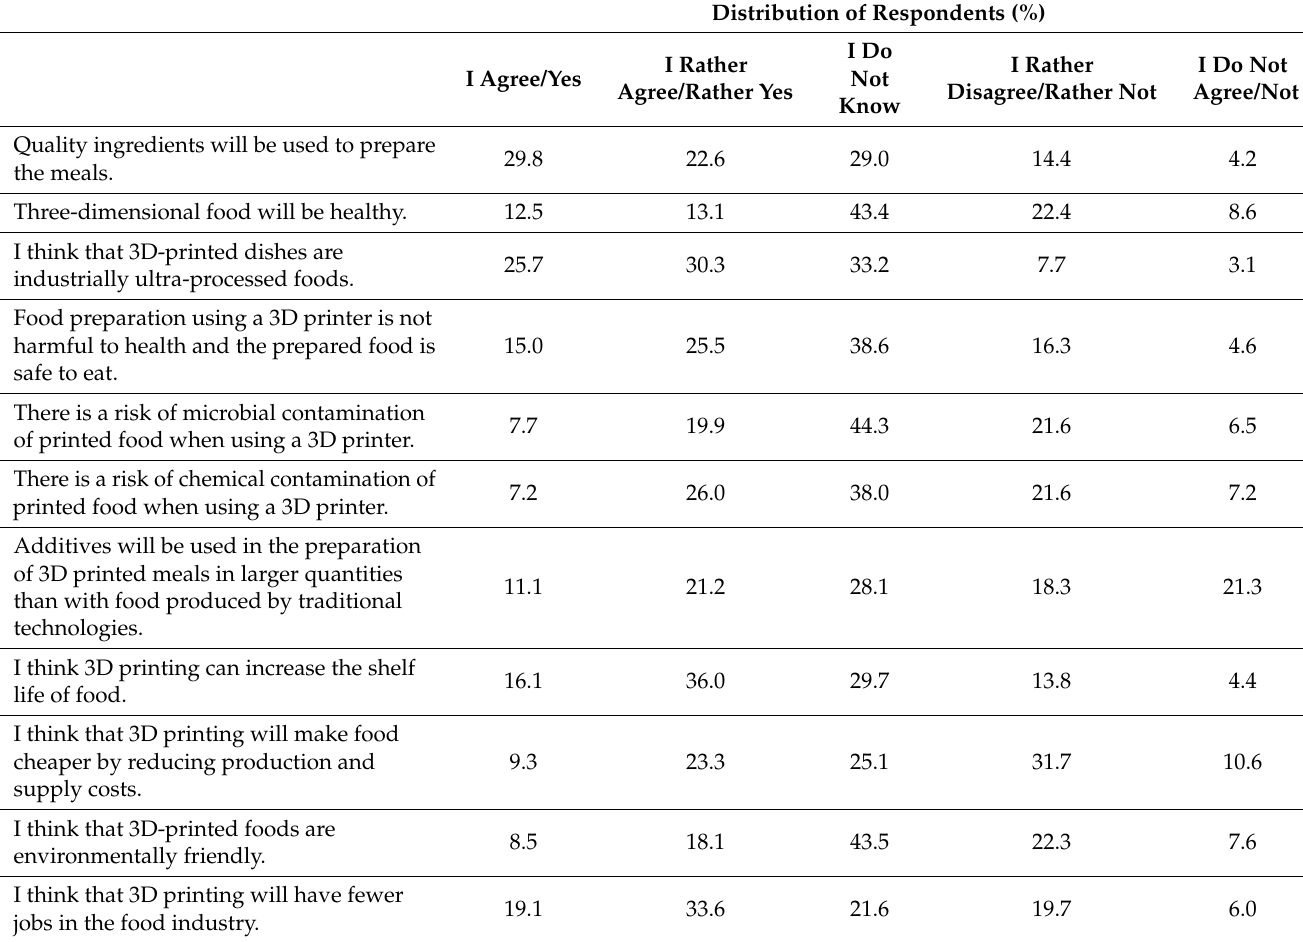
Figure 5. Respondents' worries and understandings ( n = 1156) by gender in response to the statement : “3D food will be healthy.”